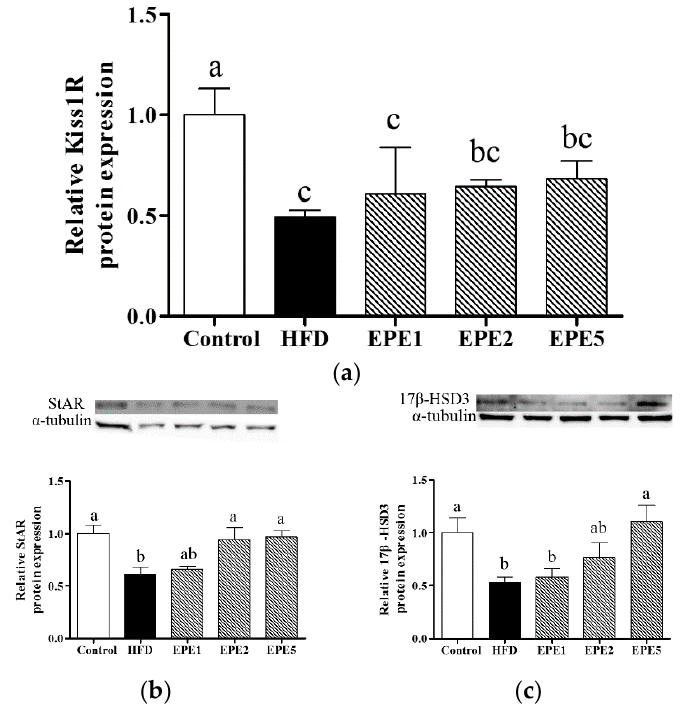
Figure 8. Effects of Echinacea purpurea ethanol extract on hypothalamus mRNA protein of ( a ) Kiss1R and testes mRNA protein of ( b ) Steroidogenic Acute Regulatory Protein (StAR) and ( c ) 17 β -HSD3 in HFD-induced obese rats after 5 weeks. Data shown as the mean ± S.E.M. ( n = 5). The values with different superscript letters ( a , b ) are significantly different ( p < 0.05), as determined via one-way ANOVA, and were analyzed by Duncan’s multiple range test.